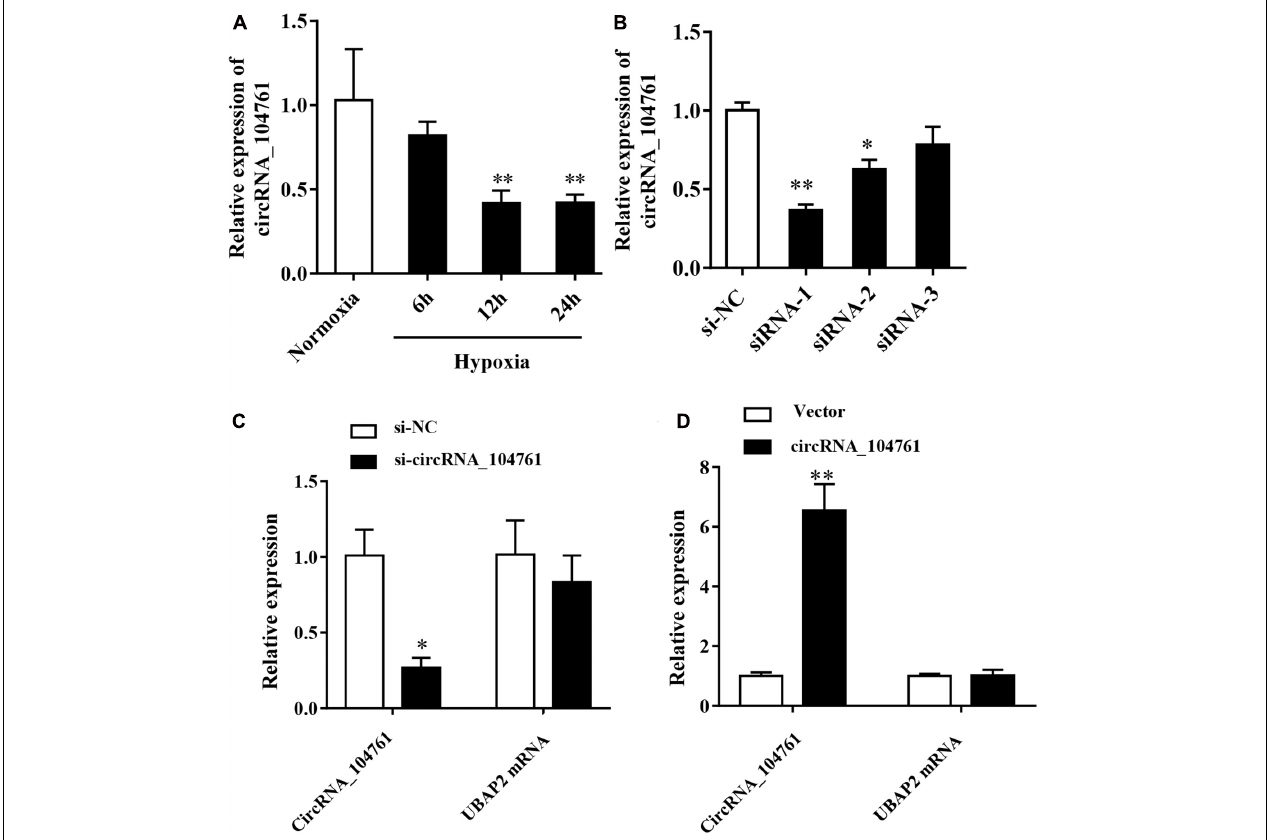
FIGURE 6 | Expression of circRNA_104761 in hypoxic human cardiomyocytes AC16 and the circRNA_104761 editing efficiency. (A) Expression of circRNA _ 104761 in AC16. (B) The down-regulation efficiency of three siRNAs (siRNA-1, siRNA-2, and siRNA-3). (C) The effect of siRNA-1 on endogenous circRNA_104761 and its source gene UBAP2. (D) The over-expression efficiencies of circRNA_104761 and UBAP2. * p < 0.05 and ** p < 0.01.